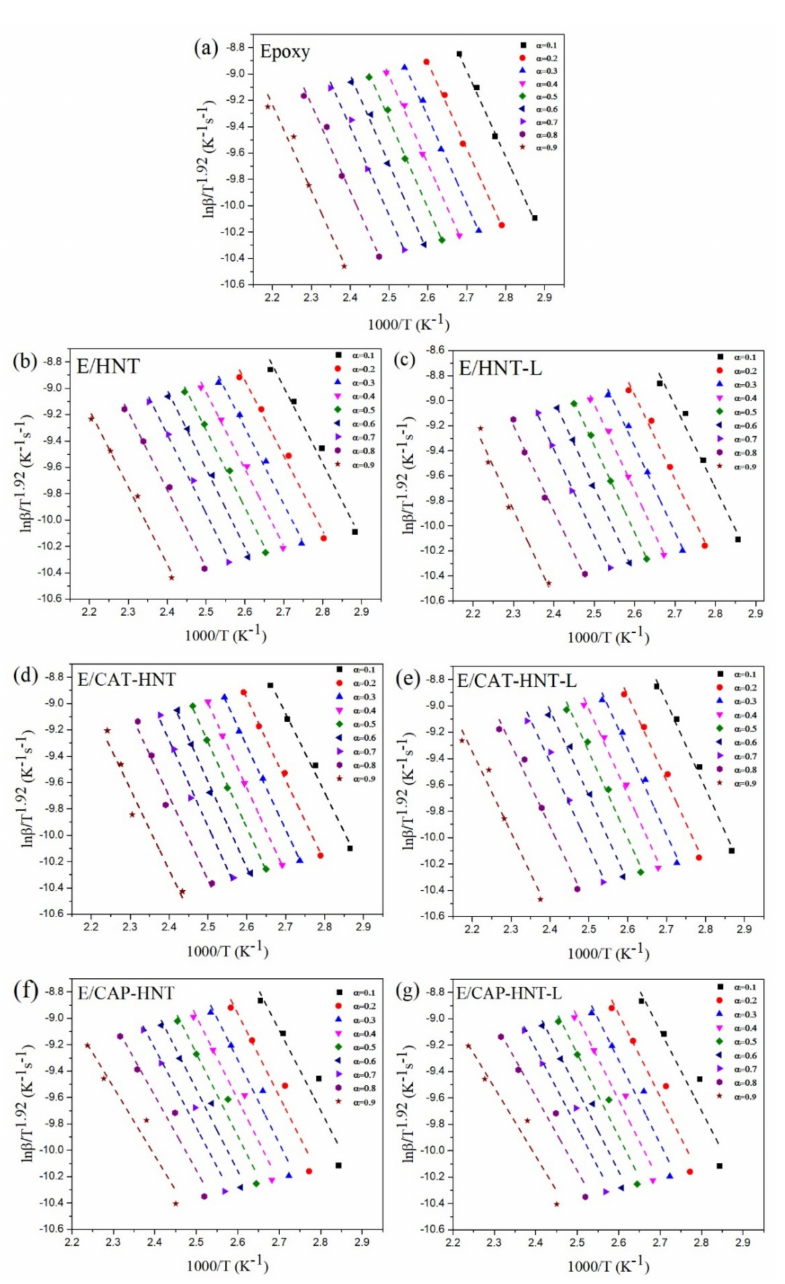
Figure A3. ( a – g ) Plots of ln( β / T 1.92 ) vs. 1/ T for prepared samples based on KAS